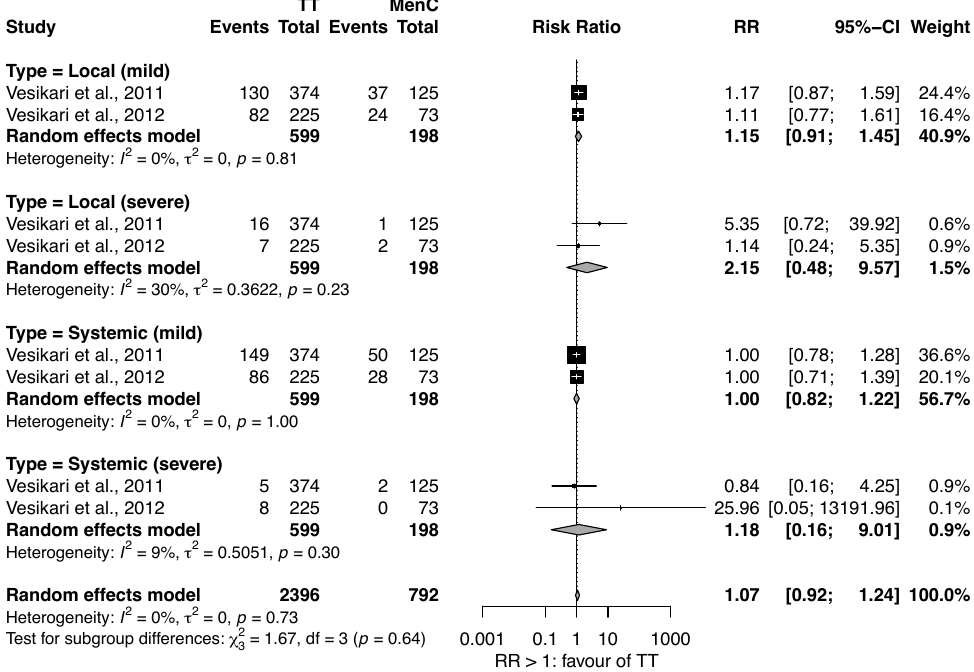
Figure A4. Safety of MenACWY-TT vs. MenC (Serogroup C). Subgroup analysis for 12–23 months age group